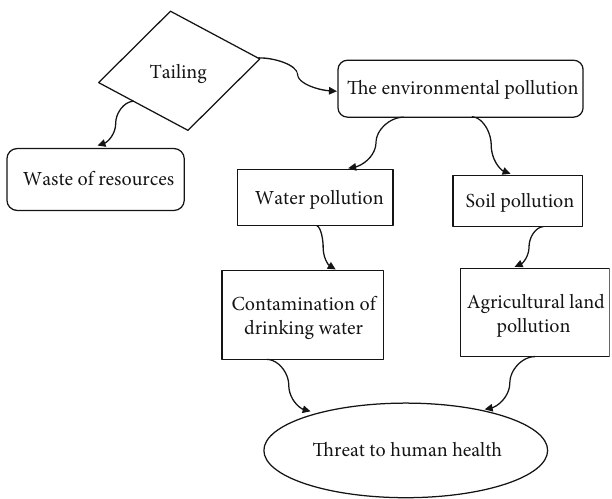
Figure 1: The harm of tailing